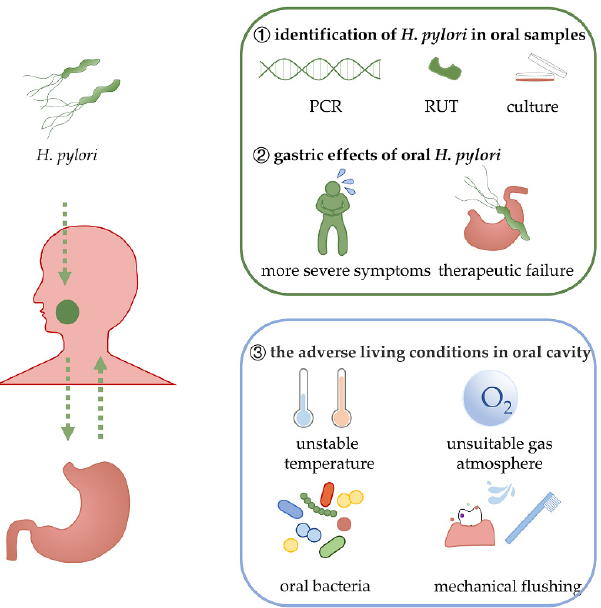
Figure 1. The oral cavity is a potential source for H. pylori gastric reinfection. However, the oral cavity seems not to be an ideal habitat for H. pylori , owing to the unstable temperature, high O 2 tension, and varied bacterial composition [13,14]. Therefore, survival strategies of living H. pylori in the oral cavity remain to be investigated. The green arrows symbolize the common transmission pathway of H. pylori . PCR, polymerase chain reaction; RUT, rapid urease test.